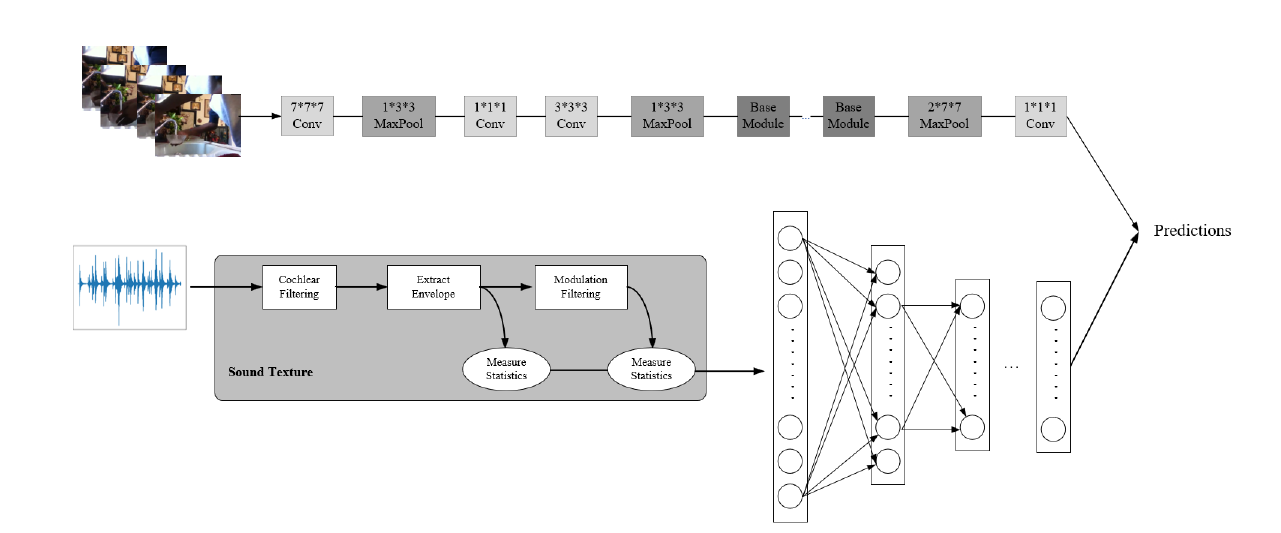
Figure 4. The simplified structure of the two-stream neural network (A-IN).